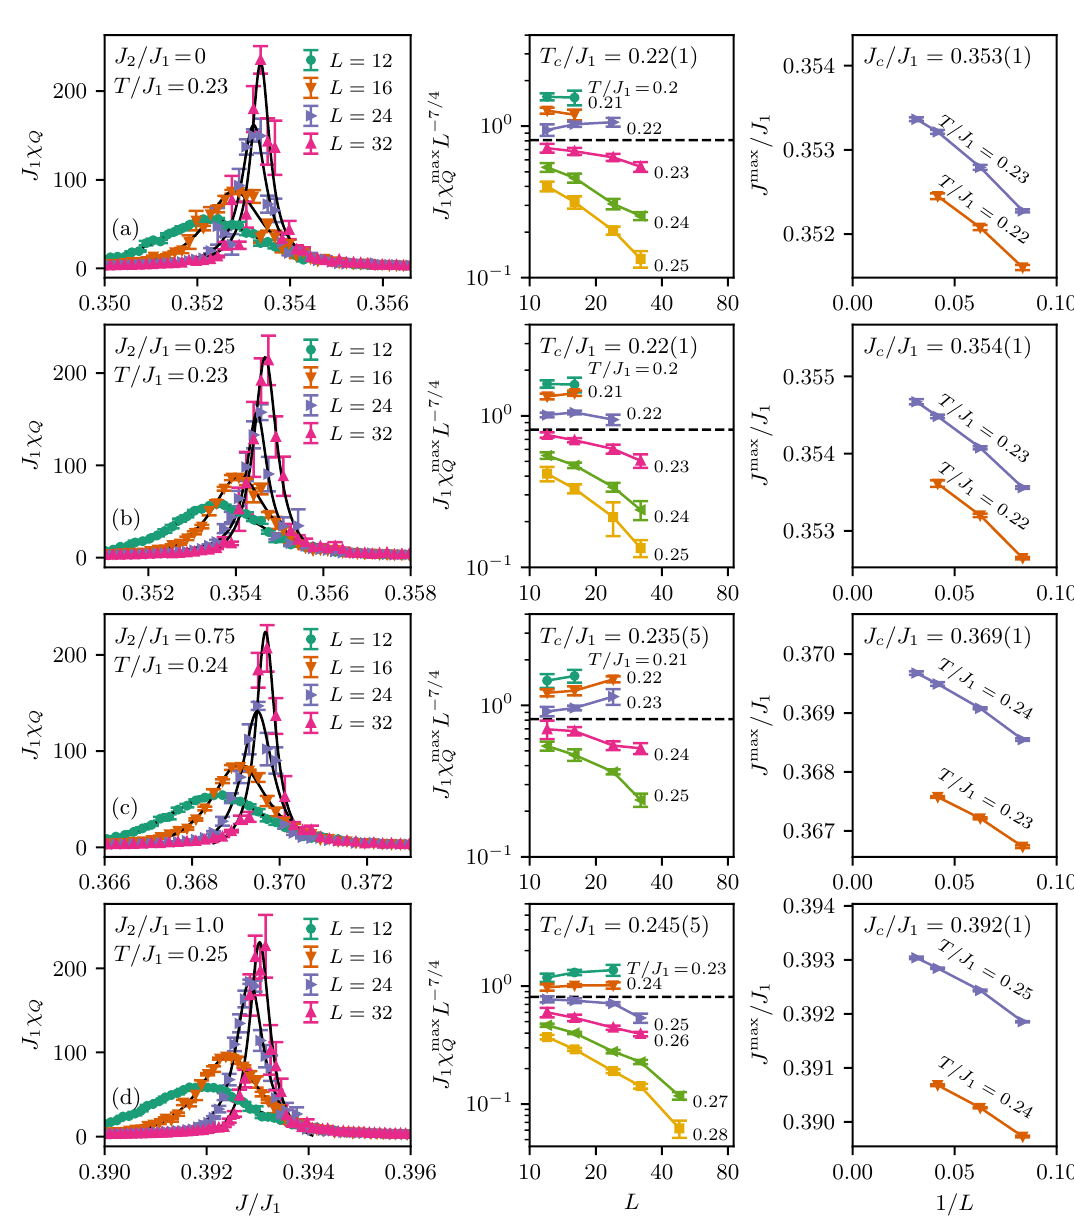
Figure 5: Determination of the critical point of the FFTL model for different intra- / J trimer couplings, J , by finite-size scaling of the maximum in the quartet suscepti- 2 1 ( T , J ) , computed along several fixed- T cuts. (left column) χ bility, χ Q different L . The maxima are fitted using a Lorentzian (black). (center column) Scal- ing of the maximum value, χ max , normalized by the power-law form, L γ/ν = L 7 / 4 , Q expected for the 2D Ising universality class. (right column) Scaling of the position, J max , of this